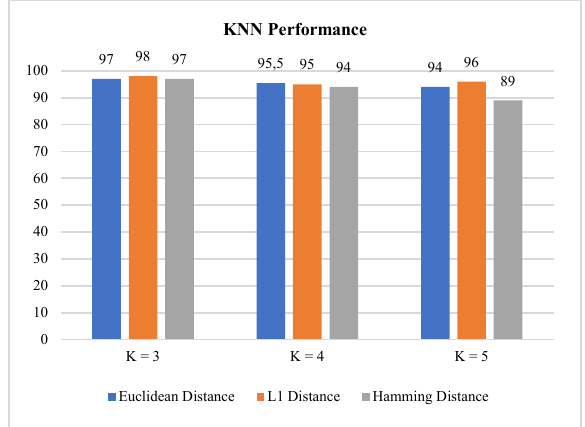
We have concluded that on average Hybrid classifier is better than SVM and KNN on the basis of the metrics depicted in figure below. Confusion matrix also plotted to show the number of tests and number of true positives, true negatives, false positives and false negatives in order to show the optimized power of our classifier.